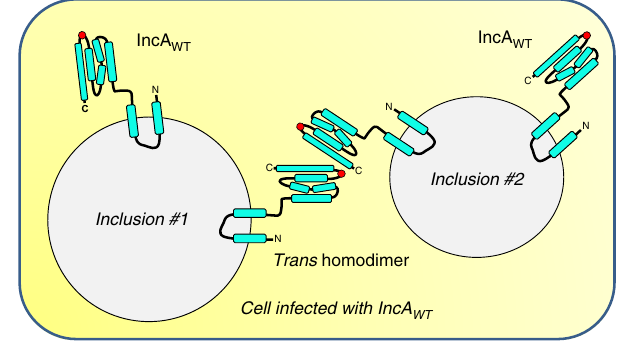
Fig. 6 Model of IncA-mediated homotypic fusion of C. trachomatis inclusions. Schematic diagram of a cell infected by C. trachomatis that expresses IncA WT . Each inclusion displays monomeric IncA WT . The fusion of inclusion membranes requires the formation of trans -homodimers of IncA WT , which interact via the C-terminal helix H D and the H clamp (highlighted with a